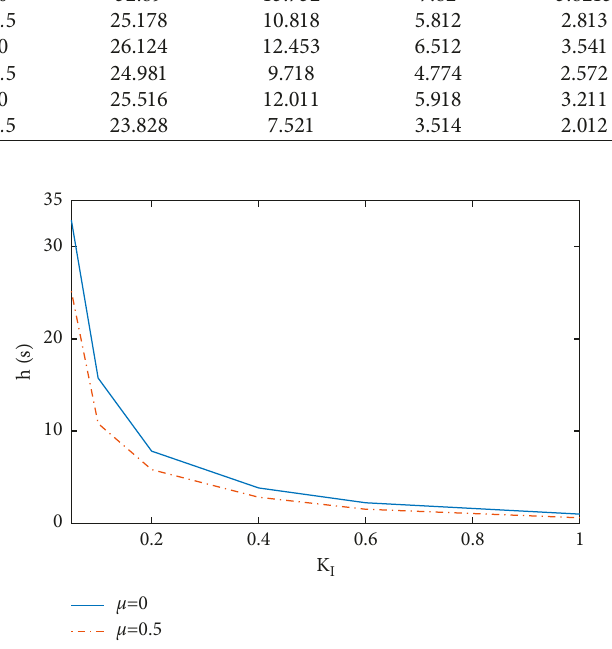
Figure 2: Delay margin h ∝ K